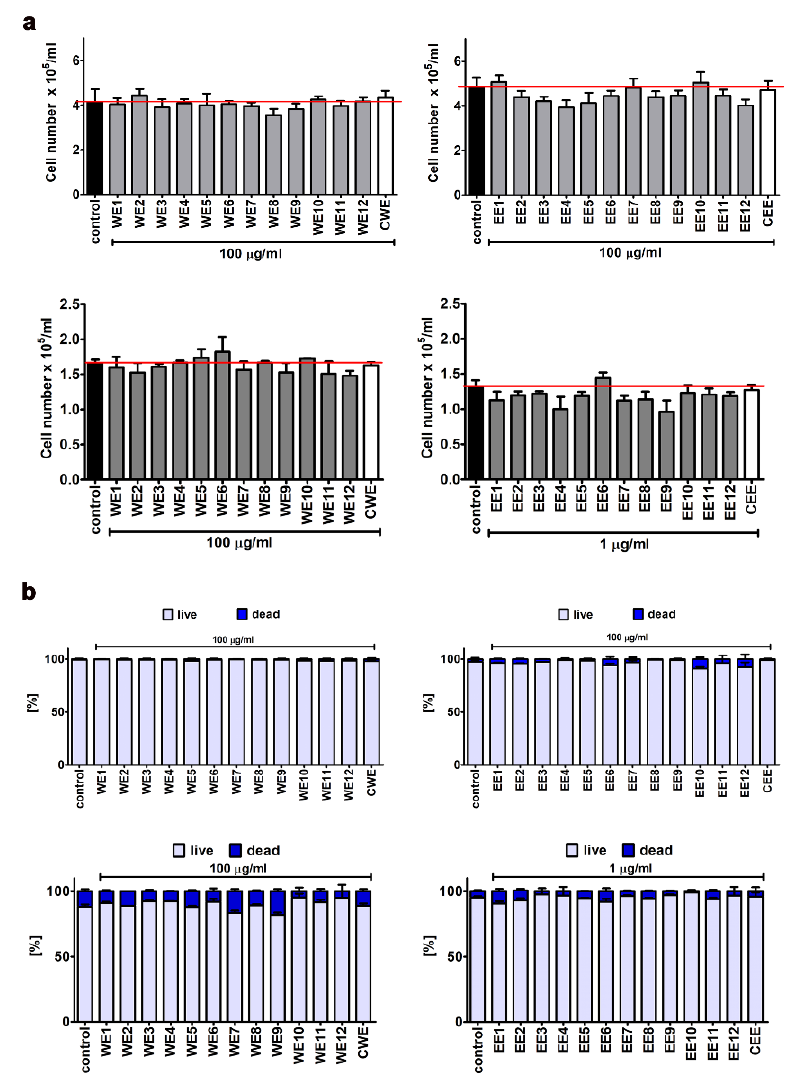
Figure 5. Extract-mediated changes in BJ and HEK cell numbers ( a ) and the levels of necrotic cells (trypan blue exclusion assay) ( b ). ( a ) Cell number was analyzed using TC10 ™ automated cell counter. To emphasize extract action, a red horizontal line is added. Black bars indicate control conditions, white bars indicate treatments with control extracts (CWE or CEE) and grey bars indicate treatments with modified water or ethanolic extracts. ( b ) BJ and HEK cells were incubated with 0.4% trypan blue and dead cells with porous cell membranes (blue-stained cells) were automatically calculated (%) using TC10 ™ automated cell counter. ( a , b ) Upper panel: BJ cells; lower panel: HEK cells. The e ff ects of water extracts (WE, twelve modified clones from WE1 to WE12) and ethanolic extracts (EE, twelve modified clones from EE1 to EE12) are shown. Control clone water extract is denoted as CWE and control clone ethanolic extract is denoted as CEE. Bars indicate SD, n =